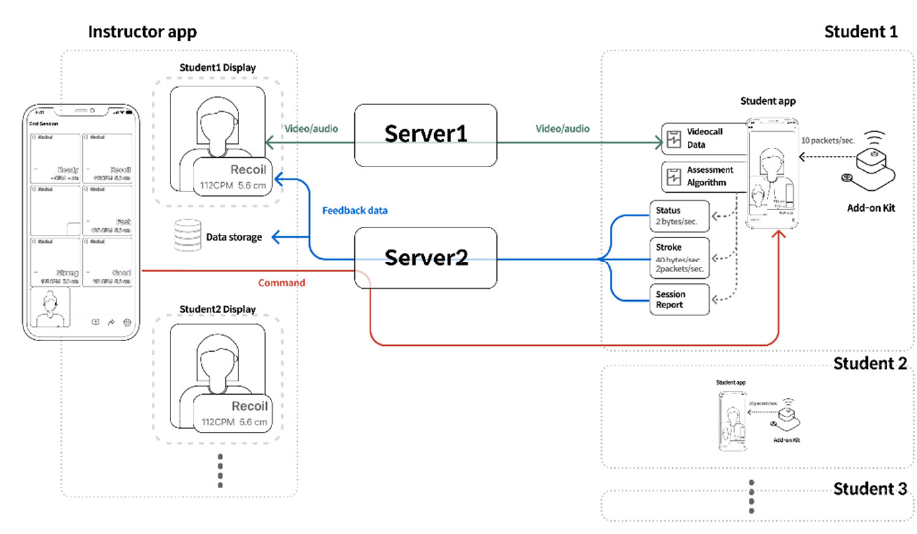
Figure 2. System architecture for remote skill training.